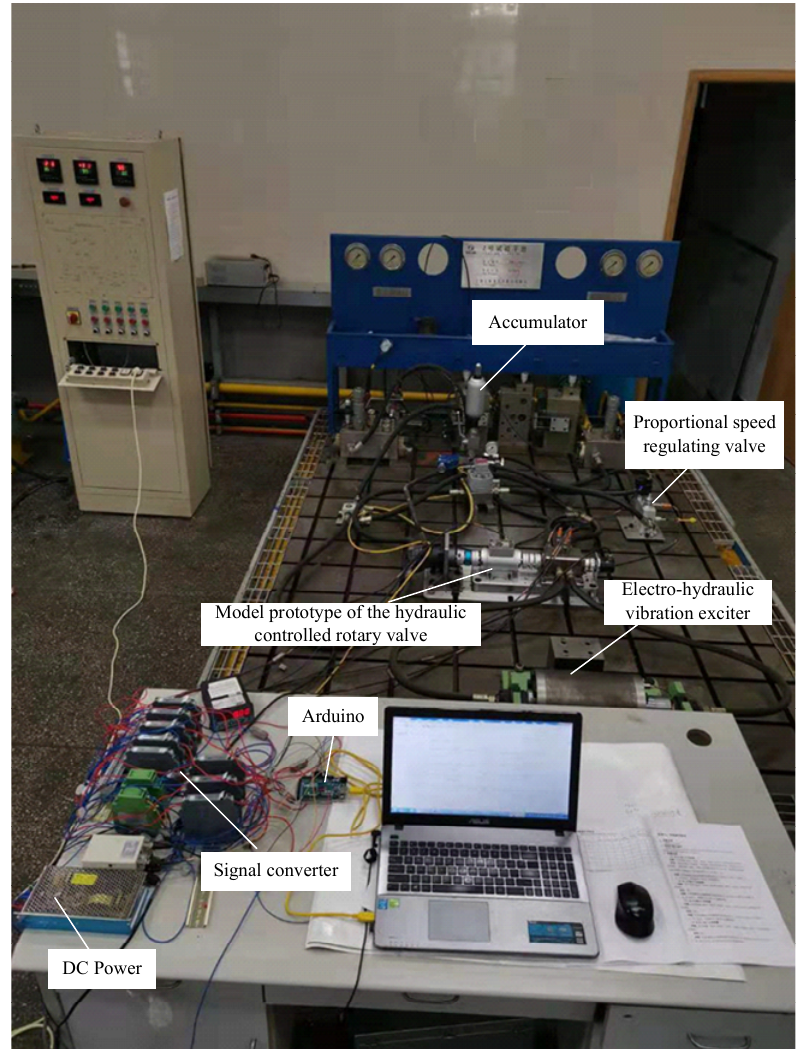
Figure 37. The experimental bench of the hydraulic controlled rotary valve excitation system.